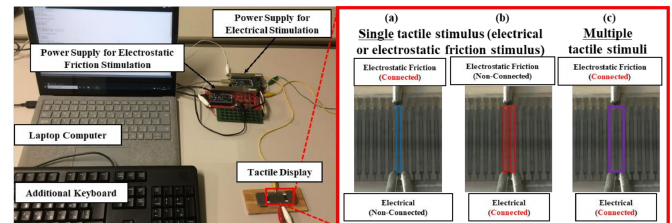
Figure 6. Photograph of the experimental